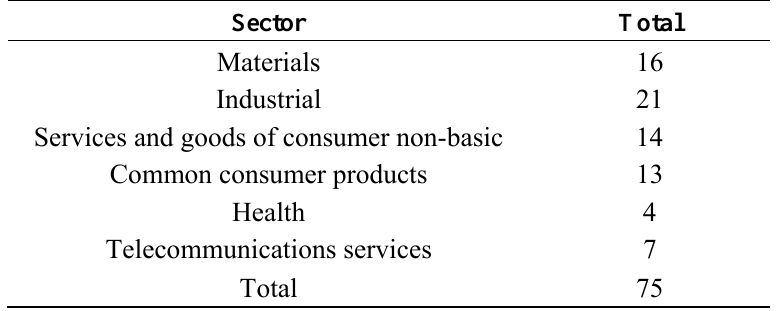
Table 1. Number and percent of family and non-family firms by